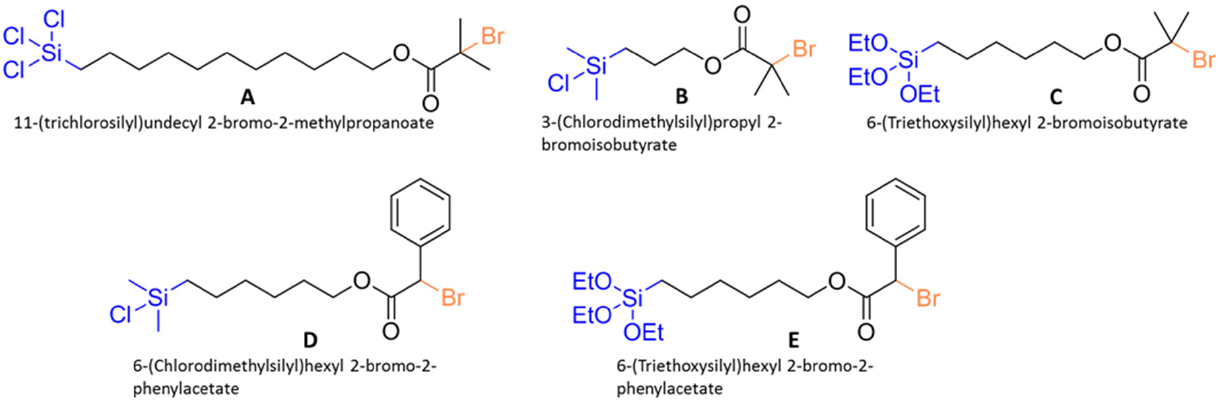
Figure 12. Different compounds containing both an ATRP initiator (orange) and a coupling moiety (blue).